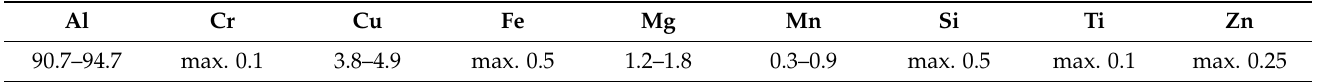
Table 1. Chemical composition of aluminum alloy A2024-T351,